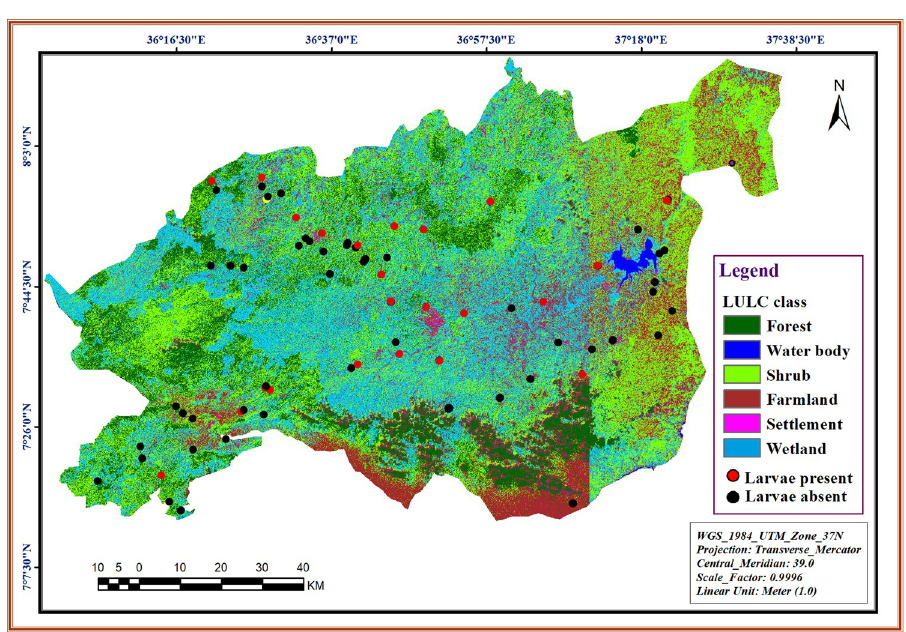
Fig 3. Spatial distribution of habitats of S . damnosum larvae in the Omo Gibe river basin, southwest